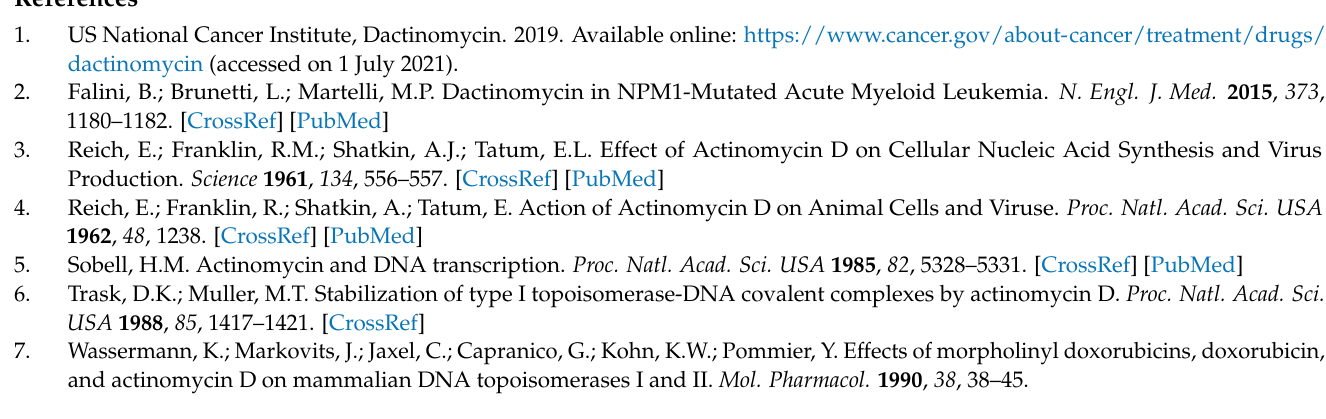
Figure S2: Coating strategies to avoid non-specific binding of actinomycin D, Table S1: Recovery data, Table S2: Calibration curves of validation batches, Table S3: Summary of quality control results for plasma actinomycin D, Table S4: Summary of quality control results for actinomycin micro-dialysate, Table S6: Summary of quality control results for actinomycin D in cell homogenate, Table S7: Stability data of the plasma validation, Table S8: Results of the incurred sample reanalysis, Table S9: Summary of quality control results for actinomycin D quantification of minimally diluted QC samples, Table S10: Matrix effect data, Table S11: In vitro probe performance comparison, Table S12: Actinomycin D in vitro retrodialysis results, Table S13: Actinomycin C in vitro retrodialysis results, Table S14: Summary of quality control results for actinomycin C in